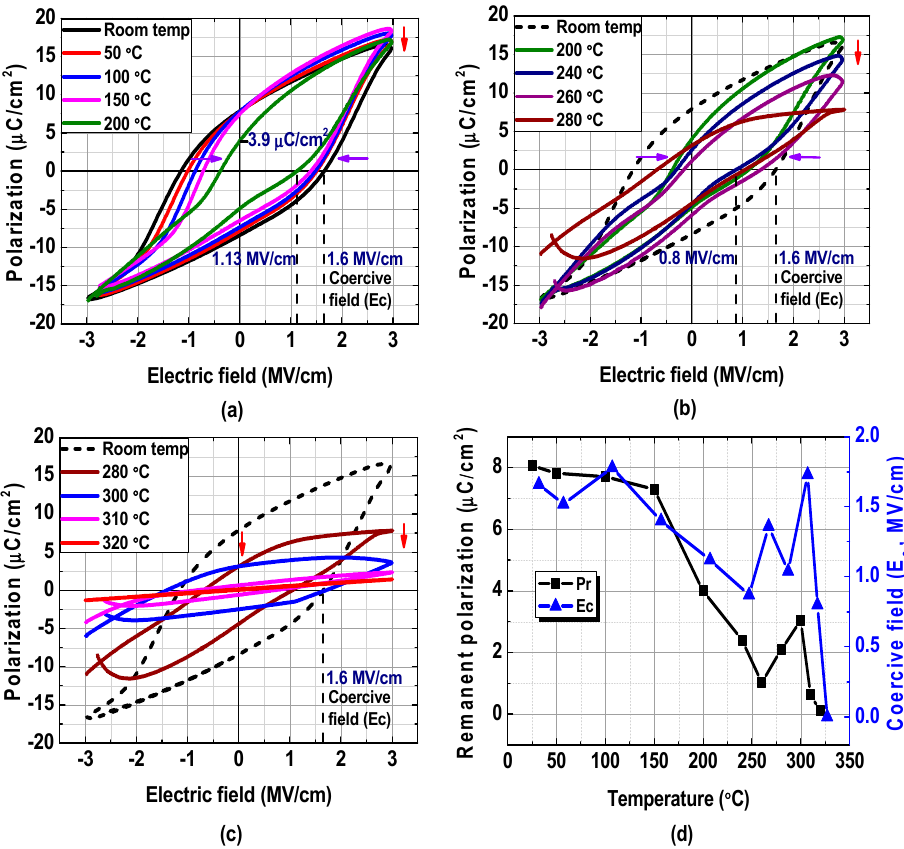
Figure 5. P–E characteristics of fabricated TiN/undoped HfO 2 /TiN MFM capacitor as a function of temperature: ( a ) from room temperature to 200 °C, ( b ) from 200 °C to 280 °C, and ( c ) from 280 °C to 320 °C. ( d ) P r and E c as functions of temperature.